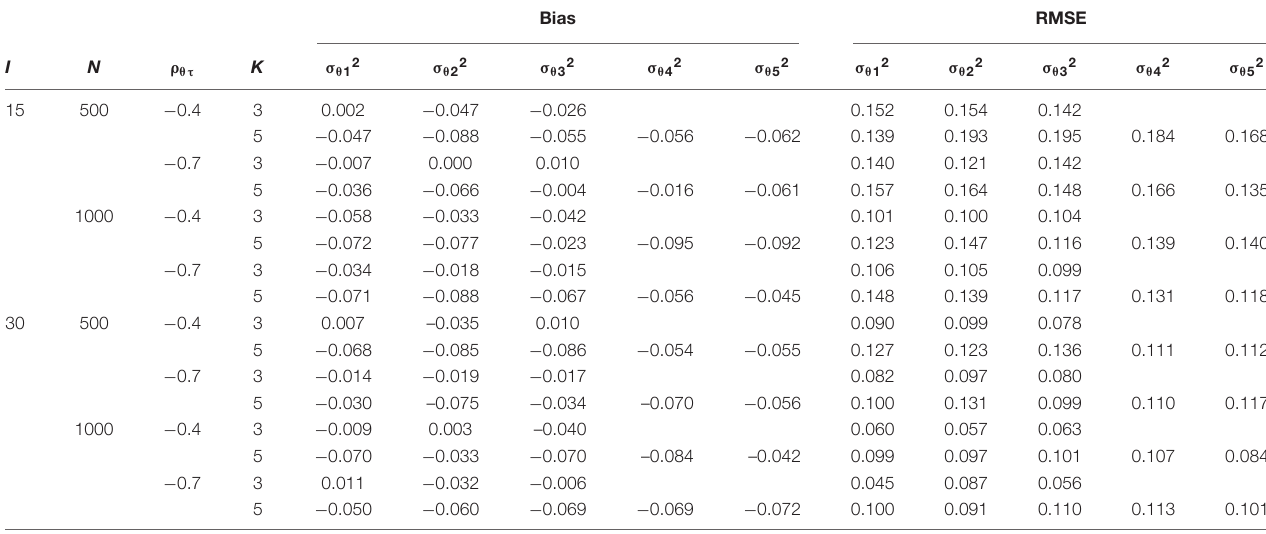
TABLE 8 | Recovery of the variance of ability in simulation study 1.